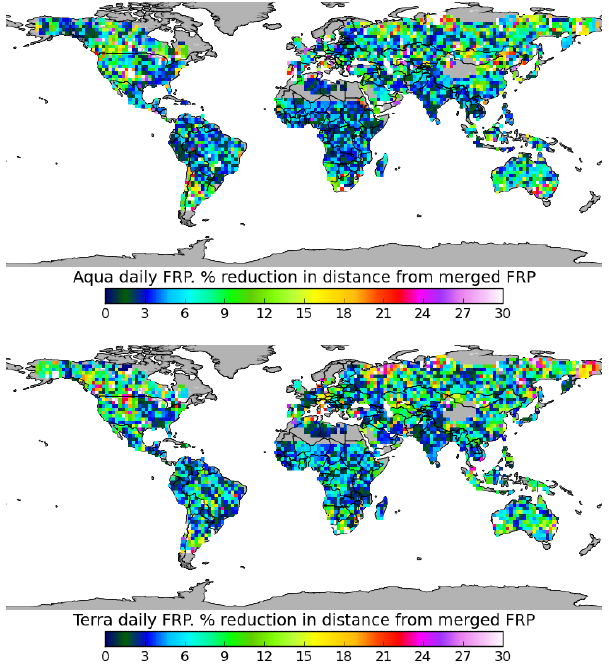
Figure 4. Square of the correlation coefficient between Aqua daily FRP (top), Terra daily FRP (bottom) and merged FRP with the adap- tive regionalization algorithm.